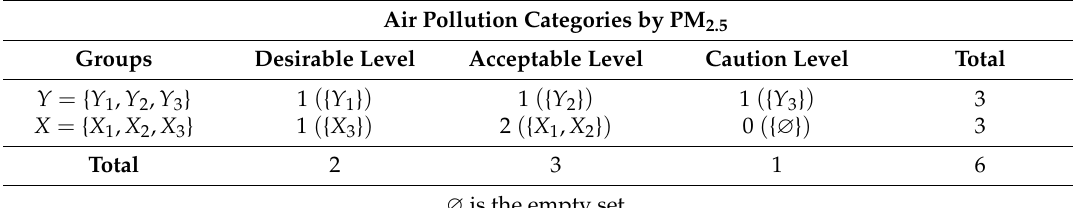
Table 3. Air pollution due to groups X and Y